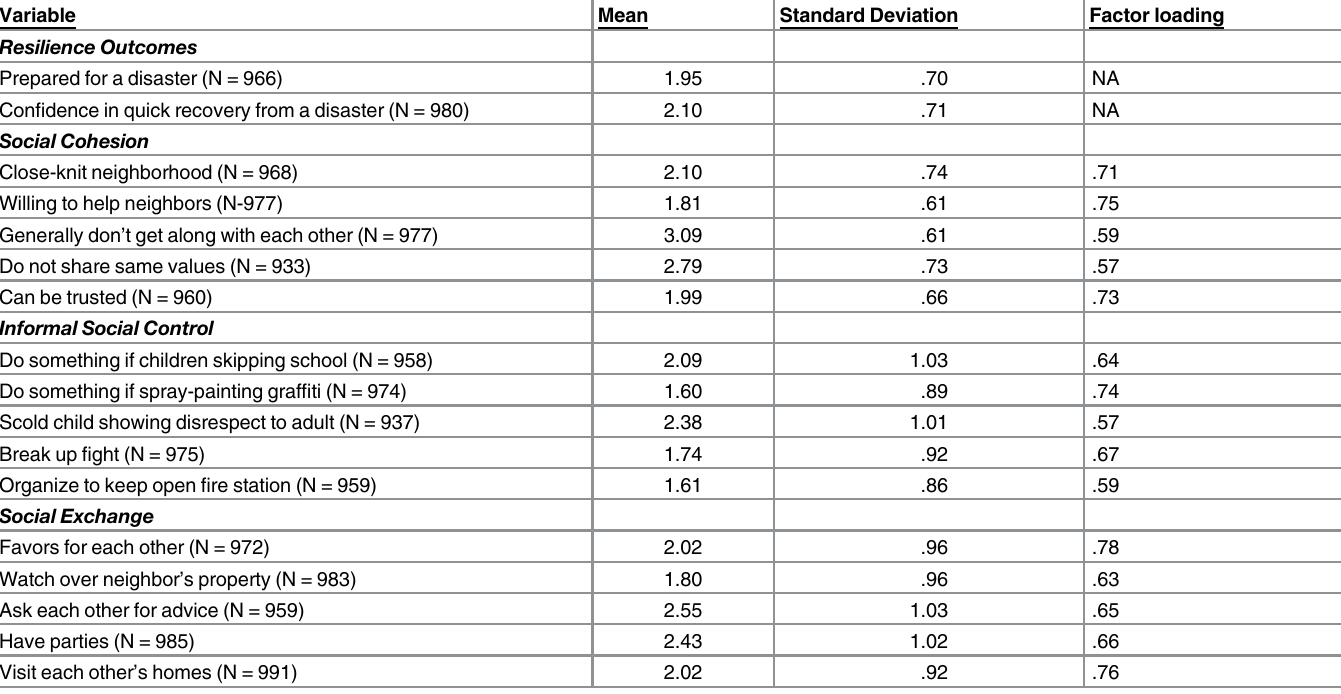
Table 1. Descriptive statistics for key dependent and independent